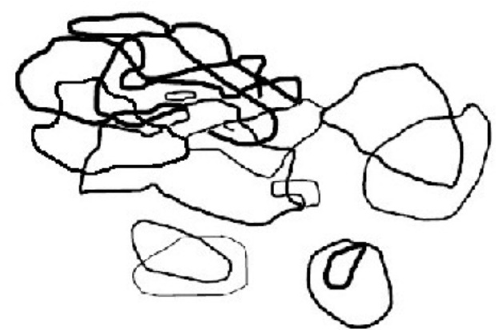
Figure 5 . One open string depicted by the slim closed curve contributes in the net.